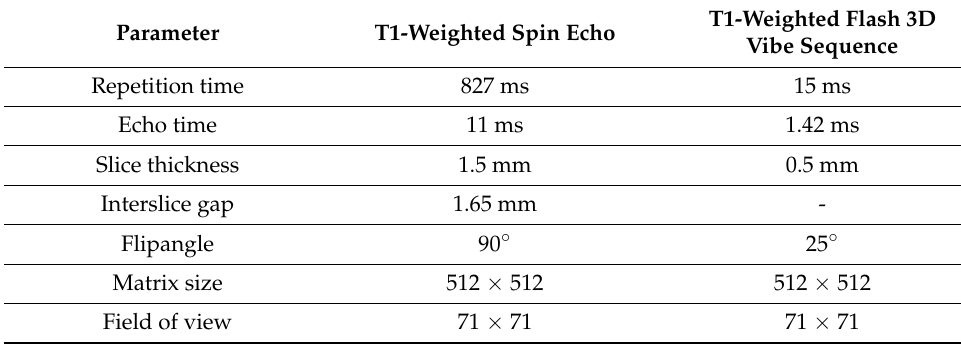
Figure 3. Visualization of transversal plane ( left ) and schematic MRI scan of the stomach in this plane ( right ). 1 — spine; 2 — forestomach; 3 — limiting ridge; 4 — glandular stomach. Table 3. MRI parameter for all